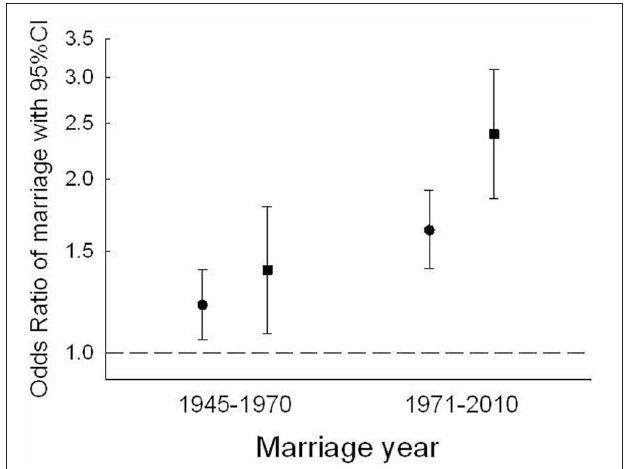
FIGURE 4 | Odds Ratios of boys with BMIs above the 90th ( (cid:129) ) or 95th ( (cid:2) ) percentile marrying girls similarly above the 90th or 95th BMI percentile at age 13 years compared to marriages among pairs under or equal to the 90th percentile. Differences by marriage periods p = 0 . 006, and p = 0 . 005, in pairs above the 90th and 95th BMI percentiles, respectively. ORs are adjusted for height at age 13 years as well as marriage